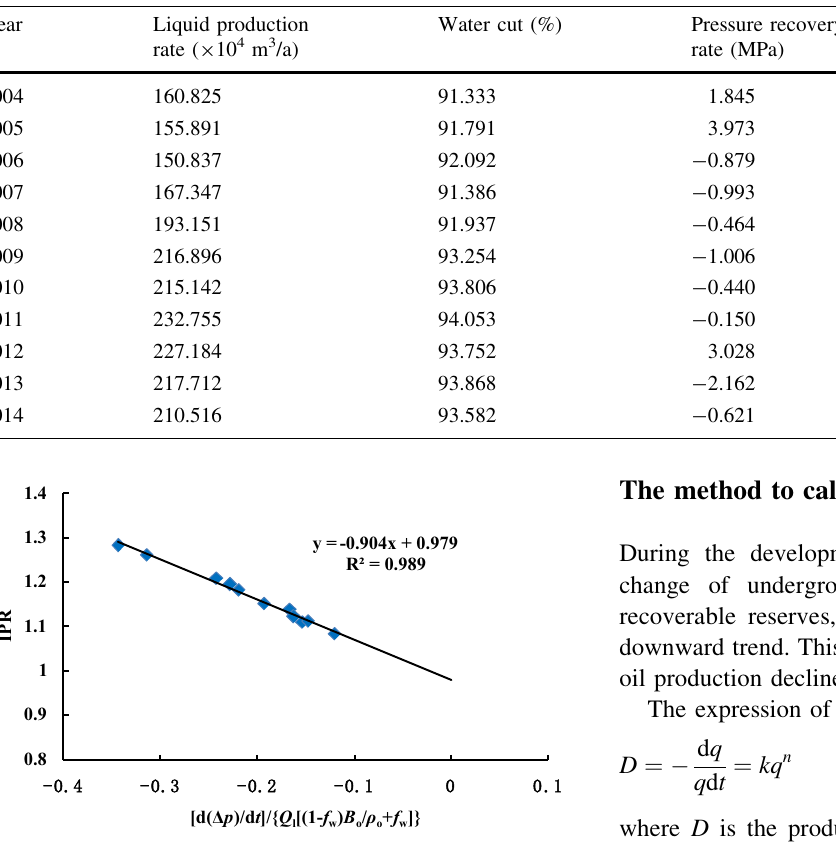
Table 2 Production data of M oilfield Year Liquid production rate ( 9 10 4 m 3 /a)